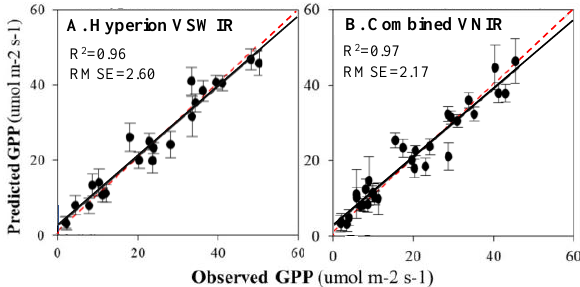
Figure 5 . Predicted versus observed gross primary production (GPP) derived using partial least square regression (PLSR) with Hyperion (A. VSWIR, n=26) and the combined VNIR (B. Hyperion+DESIS, n=10) reflectance datasets. Table 2. Subset of key canopy traits derived using the canopy radiative transfer module (RTMo) of SCOPE with Hyperion, DESIS and the combined reflectance datasets (mean, range, coefficient of variation (CV) and order (#) of importance for the prediction). The accuracy of the prediction is evaluated in terms of root mean square error (RMSE)